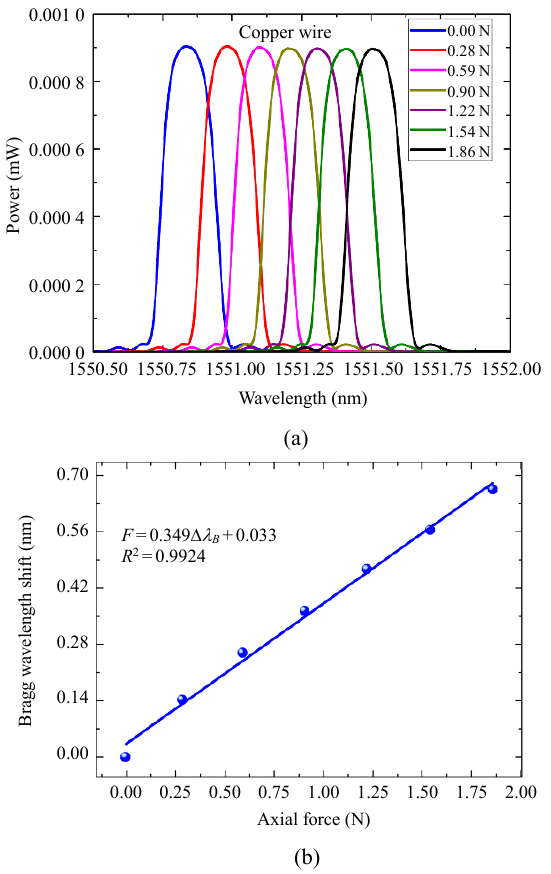
Fig. 3 Bragg wavelength of FBG changes with the loaded axial force: (a) the measured FBG reflected spectra shifts with the change of the applied axial force F and (b) the Bragg wavelength of FBG responses to the variation of the loaded axial force.